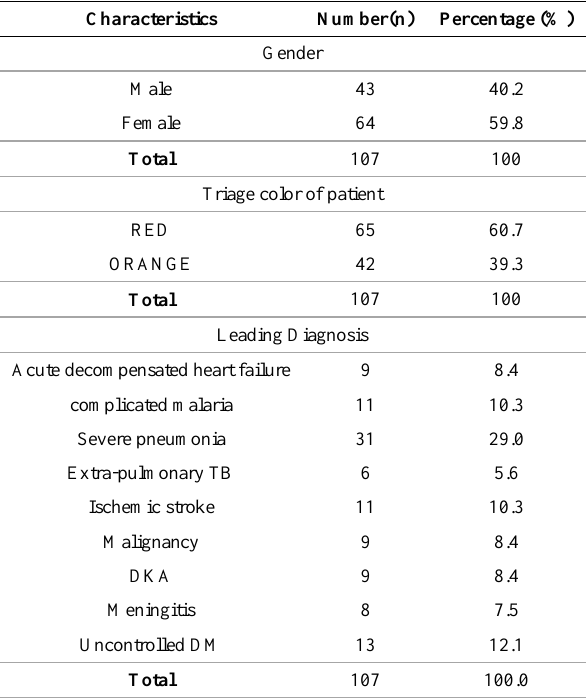
Table 2. Baseline characteristics of the study